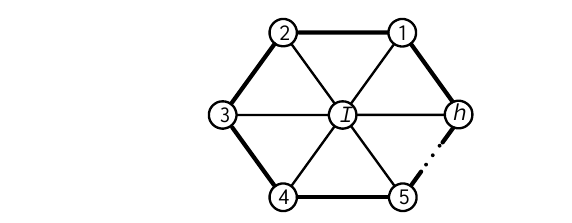
Figure 2. Single-layer artificial cobweb